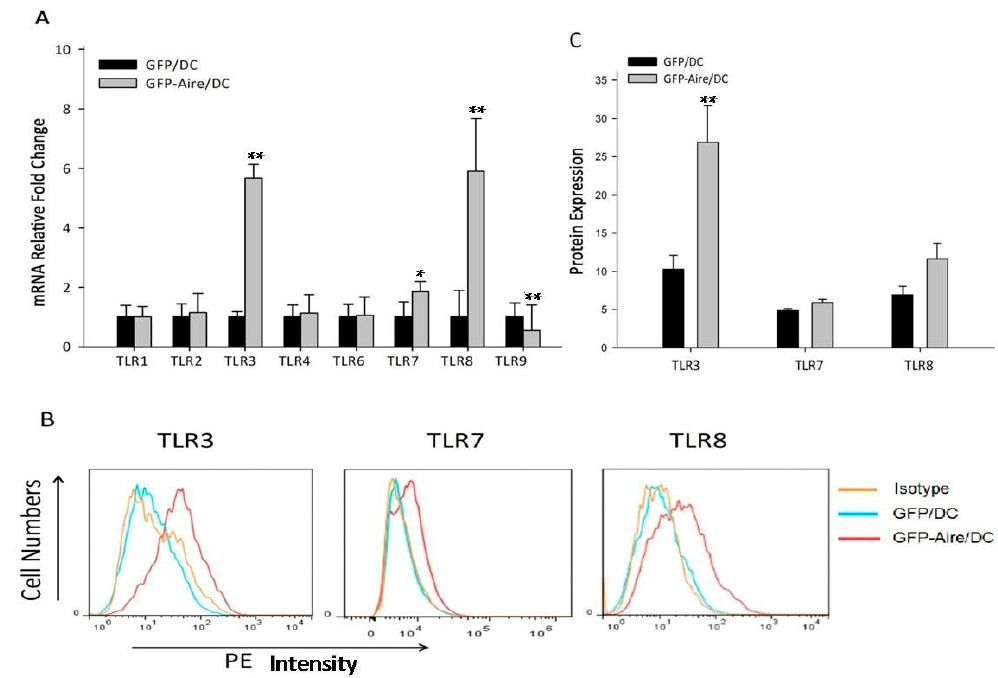
Figure 2. The effects of Aire on TLR expression in GFP-Aire/DC. ( A ) The levels of TLR1–9 transcript expression in GFP-Aire/DC and GFP/DC were detected by RT-qPCR. All qPCR data are shown as the gene expression relative to GAPDH and are depicted as fold changes relative to the expression in the GFP/DC cells, which was normalized to 1; ( B ) The TLR1, TLR3, and TLR8 protein expression levels in stably-transfected DC2.4 cells were analyzed by FCM. The proteins were detected with anti-TLR3, anti-TLR7, and anti-TLR8 antibodies, respectively, as well as a PE-conjugated goat anti-rabbit IgG; and ( C ) The bar graph depicts the expression levels of TLR3, TLR7, and TLR8 according to the MFI values. Data are shown as the means ± SD from three to six independent experiments. GFP-Aire/DC vs. GFP/DC: * p < 0.05; ** p < 0.01. Table 1. The effects of Aire on the Poly (I:C)-stimulated phenotypic characteristics of DC2.4 cells. GFP/DC MFI % GFP/DC Poly (I:C) MFI % Poly